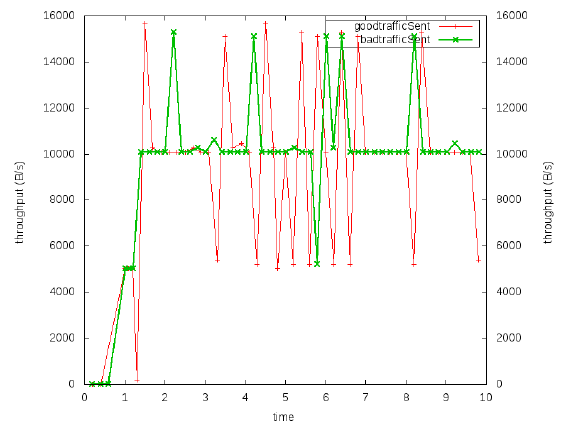
Fig. 6. Aggregate good traffic and aggregate bad traffic, as measured at the sources, when the firewall is